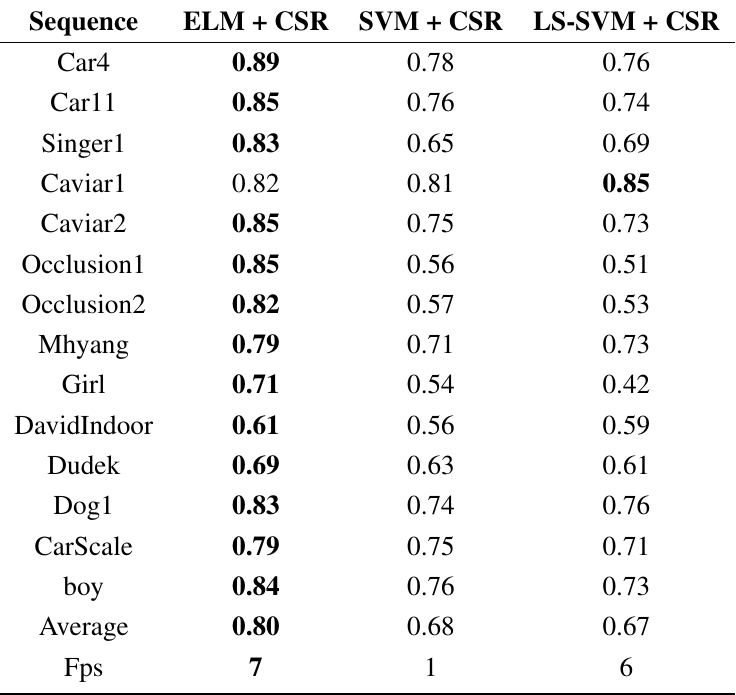
Figure 4. Some representative tracking results on three video sequences: Singer1, boy and Dudek (from left to right). Table 5. Comparisons between ELM and SVM/LS-SVM in terms of VOR ( % ) and Fps. CSR, constrained sparse